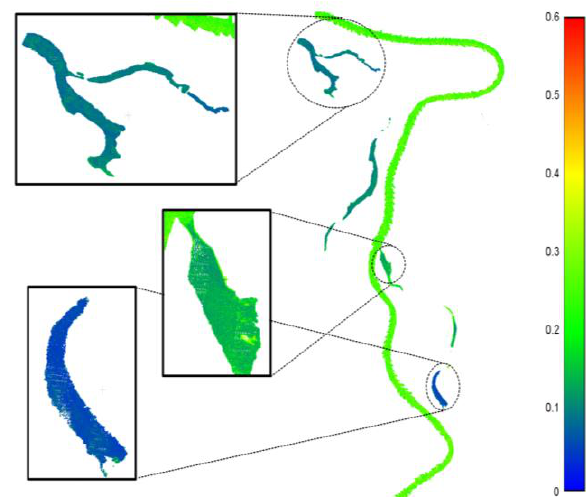
Figure 10: Turbidity map of a section of the river Elbe, Germany (Richter et al., 2017)